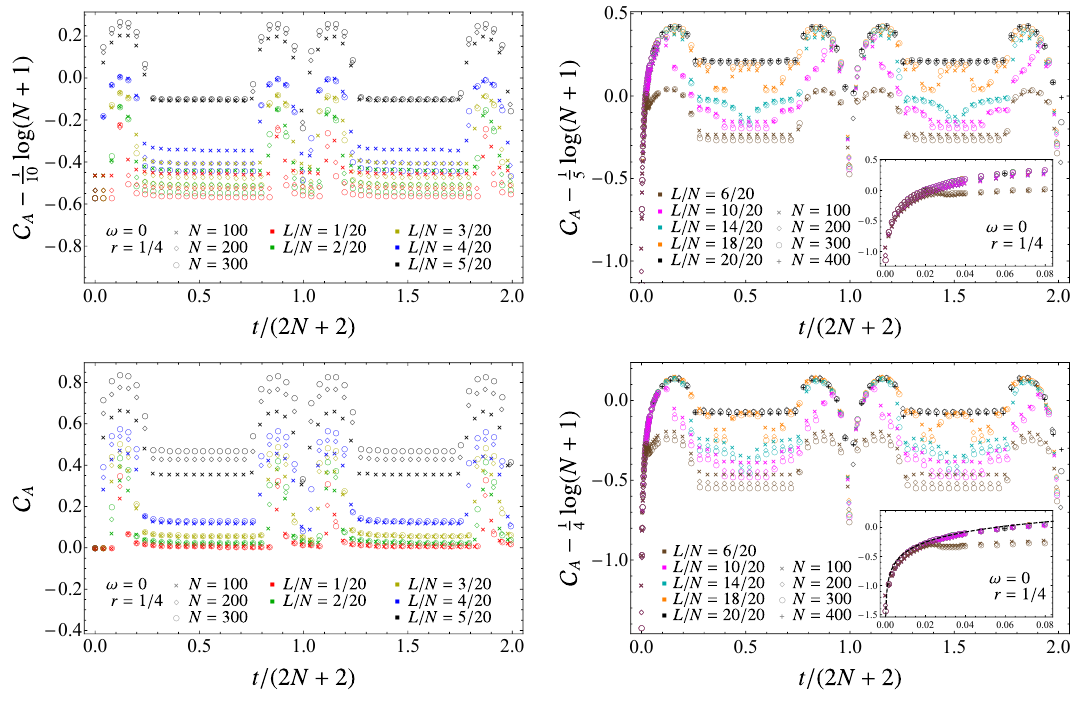
Figure 8 . Temporal evolution of the subsystem complexity C A in (4.4) for a block A made by L consecutive sites adjacent to the left boundary of harmonic chains made by N sites (see figure 1, bottom left panel) after a local quench with ω = 0 and r = 1 / 4 . The size of the blocks is L 6 Nr in the left panels and L > Nr in the right panels. The insets zoom in on the initial growth (the dashed curve in the bottom right panel corresponds to (3.25)). The data points corresponding to L/N = 1 in the right panels are also reported in the top right panel of figure